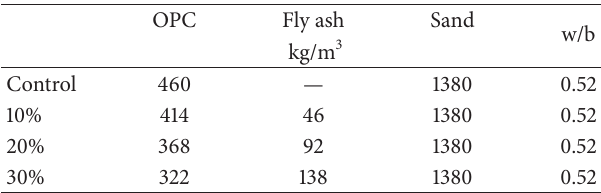
Table 3: Content of heavy metals in fly ashes (mg/kg).